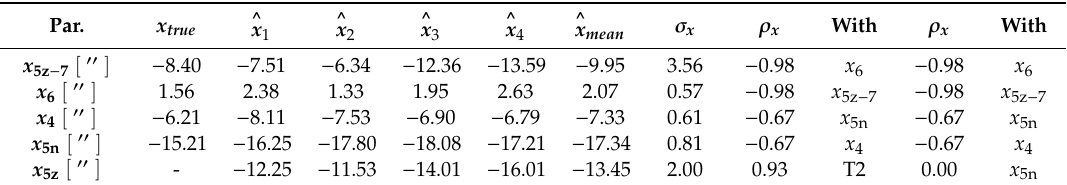
Table 4. Estimating a subset of parameters: CP values (repetitions 1–4, mean), standard deviation out of 4 repetitions, correlations with all unknowns and only between the